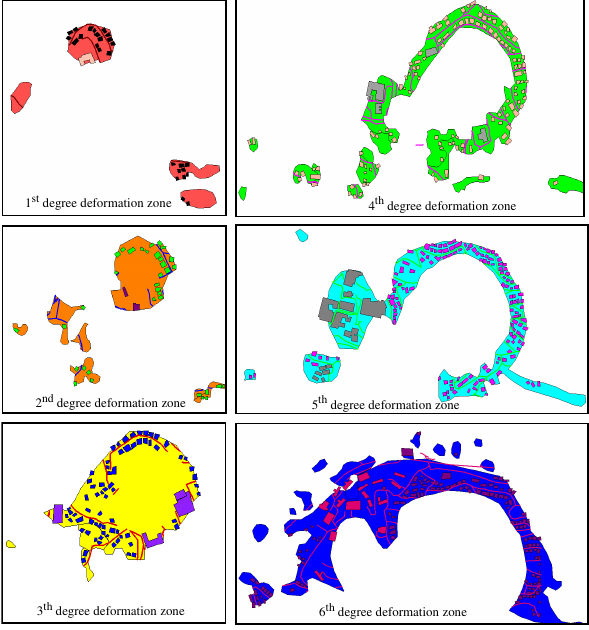
Figure 13. Structures located in the deformation zones Fig. 13. Structures located in the deformation zones.